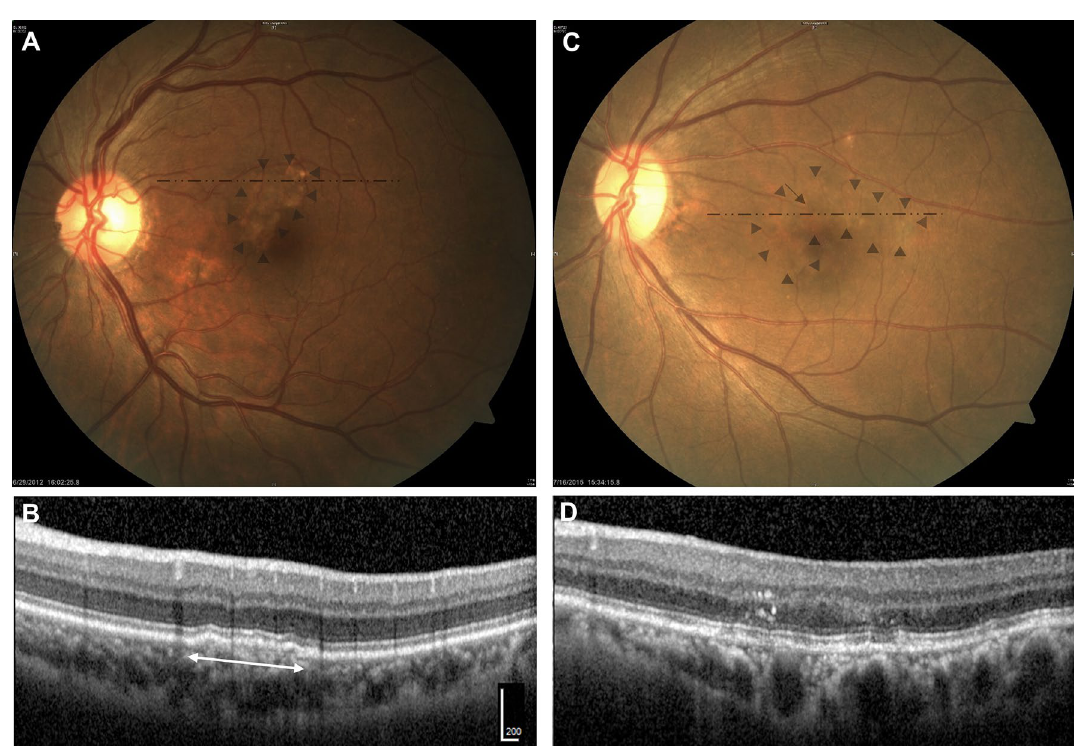
Figure 1. Representative types of pigmentary abnormalities on color fundus photography (CFP) and their corresponding optical coherence tomography (OCT) findings. ( A ) Large hypopigmentation (≥ 0.5 disc area; DA) on CFP. Well defined hypopigmented area is noted at the macula. The lesion size is 0.60 DA. The shape of the lesion is irregular and not circular or oval. Faint dash-dotted line indicates the position of OCT cross- section shown in ( B ). Faint triangles indicate the margin of the hypopigmentation. ( B ) Shallow irregular RPE elevation (SIRE) (≥ 1000 µm in length) on OCT. A 1350 µm in length, shallow, irregular RPE elevation is noted. The internal reflectivity is nonhomogenous. (Scale bar 200 µm). ( C ) Mottled area showing hypopigmentation with multiple hyperpigmentation spots on CFP. Poorly defined, irregular, mildly hypopigmented atrophic area is noted. Multiple hyperpigmented spots are located within the hypopigmented area. Faint dash-dotted line indicates the position of OCT cross-section shown in ( D ). Faint triangles indicate the margin of the hypopigmentation and faint arrow indicates the hyperpigmentation spot. ( D ) “Attenuation or disruption of RPE and/or ellipsoid zone” with intraretinal hyperreflective foci (IHRF). Multiple discontinuation and attenuation of the signal of ellipsoid zone band are observed. The attenuation of RPE band signal is noted. IHRF by RPE migration-up which corresponds to the location of the hyperpigmented spot on CFP is observed on